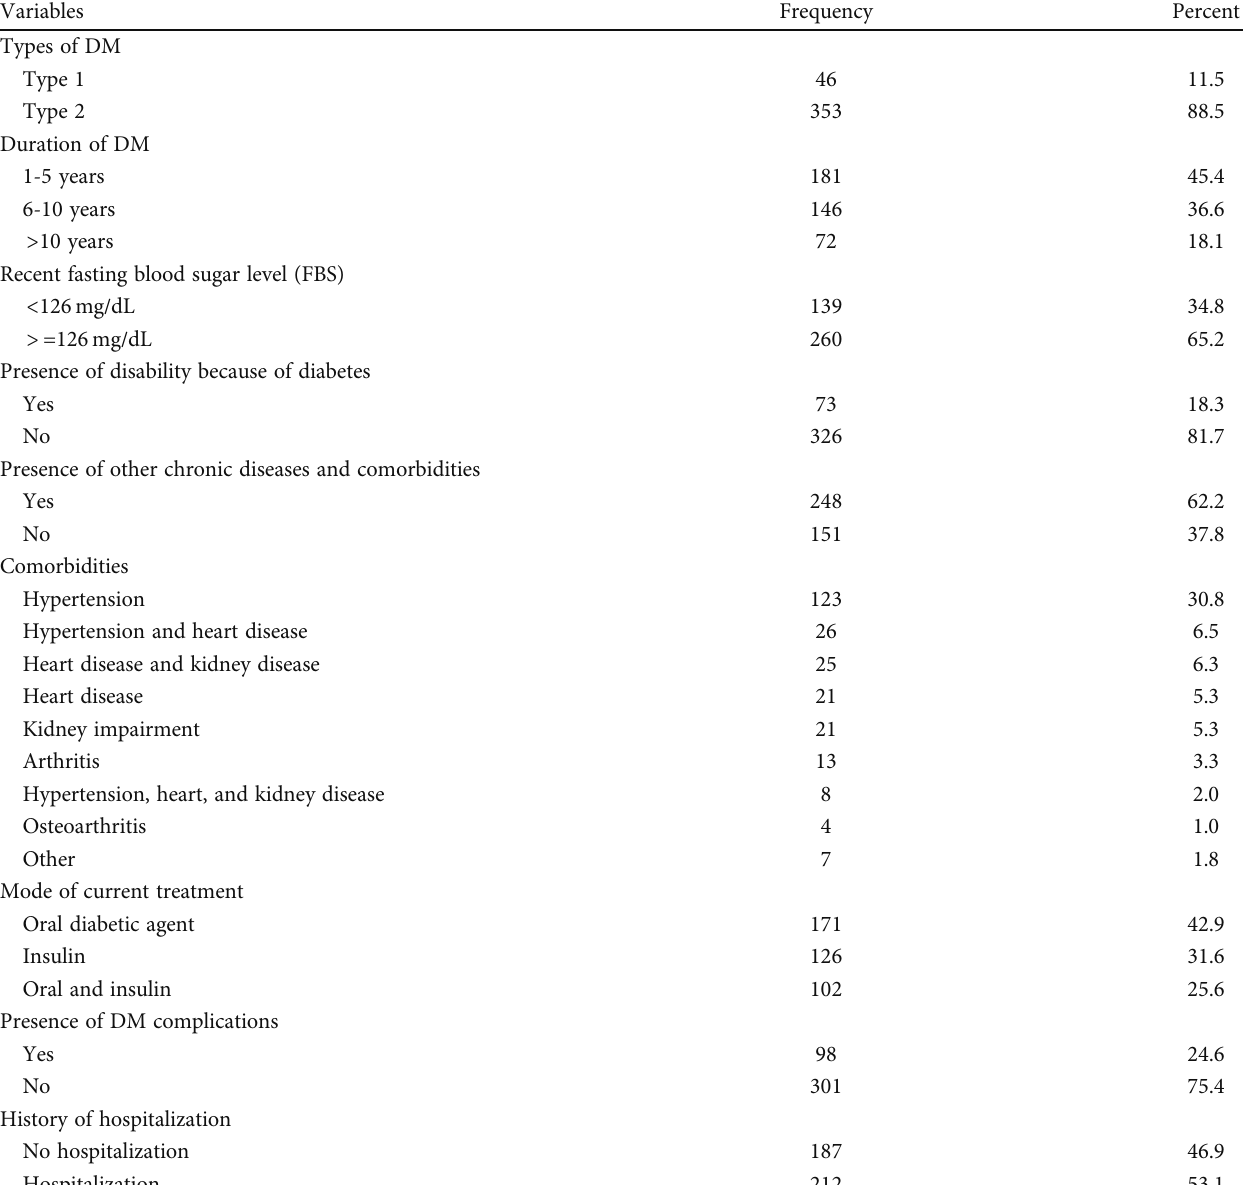
Table 3: Diabetes clinical characteristics of persons with diabetes ’ perceptions of family burden and associated factors at a university hospital ( n = 399